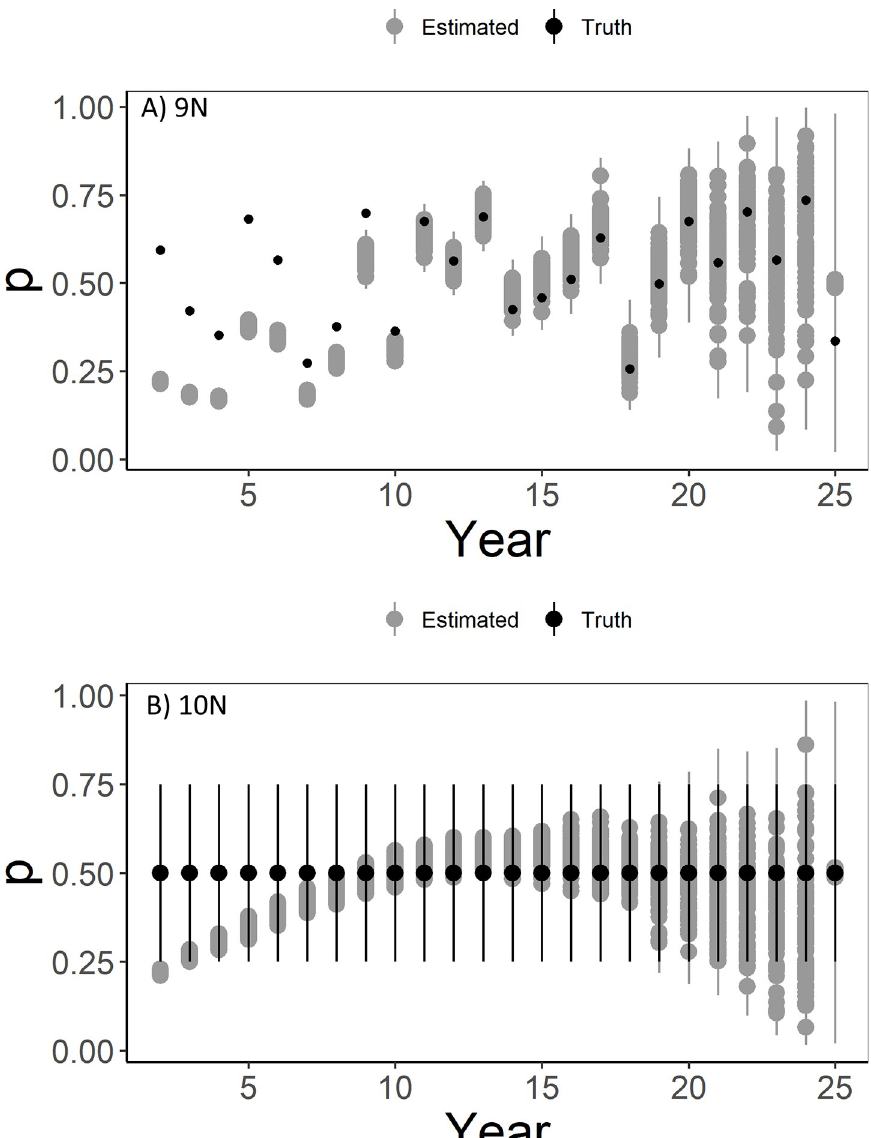
Fig 7. Detection probability estimates from models with temporally-varying detection probability. Detection probability estimates (“Estimated” in gray) of lesser prairie-chickens from an N-mixture model with detection probability varying randomly by time (A, Scenario 9N) and by time and space (B, Scenario 10N). True values of detection probability are shown in black (“Truth”) with true values of detection probability averaged over site for each year. Points represent mean and true values from each simulation and whiskers represent 95% quantiles for each simulation.